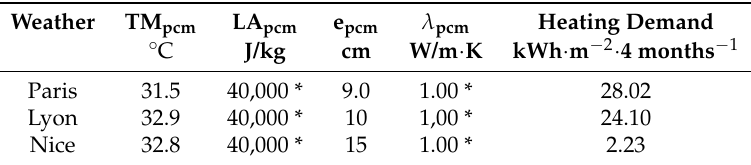
Table 6. Optimal parameters of three distinct weather conditions (optimization of the heating demand objective function).